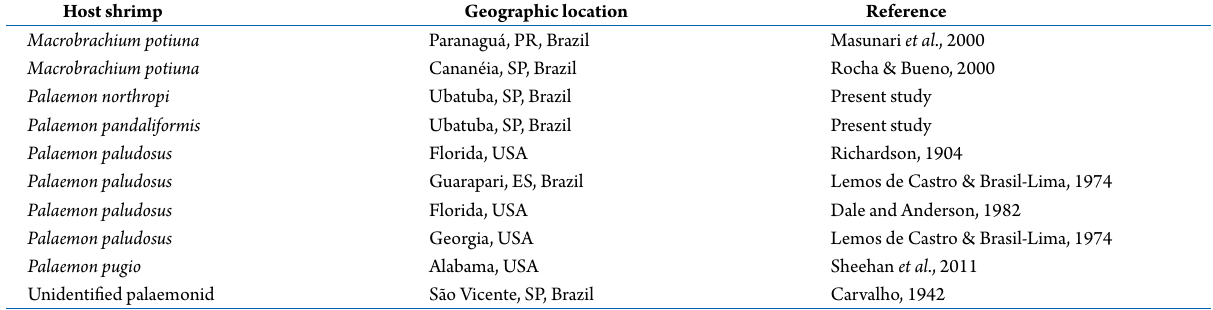
Table 3. List of palaemonid shrimps infested by Probopyrus sp. (Isopoda, Bopyridae).